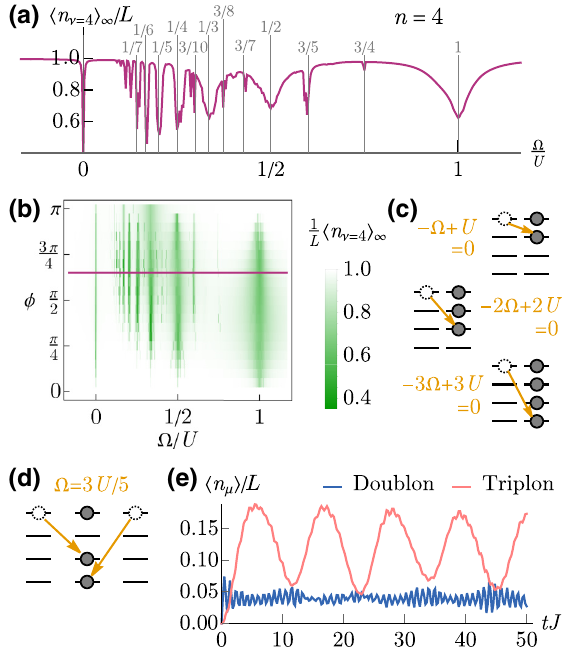
FIG. 8. (a) Long-time average population of the initially pop- ulated dressed state (cid:12)ˆ n ν = 4 (cid:4) ∞ for an n = 4 system as a function of (cid:2)/ U . The interactions are fixed at U / J = 30, the system size at L = 5, and the flux at φ = 2.0 [we use this flux rather than a sim- pler value like π/ 2 to avoid accidental cancelations of dressed tunneling matrix elements in Eq. (26)]. Resonances at (cid:2) = pU / q are labeled by their p / q values. (b) Long-time average population for the same system across the parameter space of (cid:2)/ U and φ . The purple line corresponds to panel (a). (c) Allowed spin-flip tunneling processes at the (cid:2) = U resonance. Doublons, triplons, and quadruplons can all be formed. (d) Two-step resonant pro- cess at the (cid:2) = 3 U / 5 resonance, forming a triplon. (e) Time evolution of fraction of lattice sites with exclusively two atoms (doublon) and three atoms (triplon) at the (cid:2) = 3 U / 5 resonance, for parameters L = 6, U / J = 30, (cid:2)/ J =